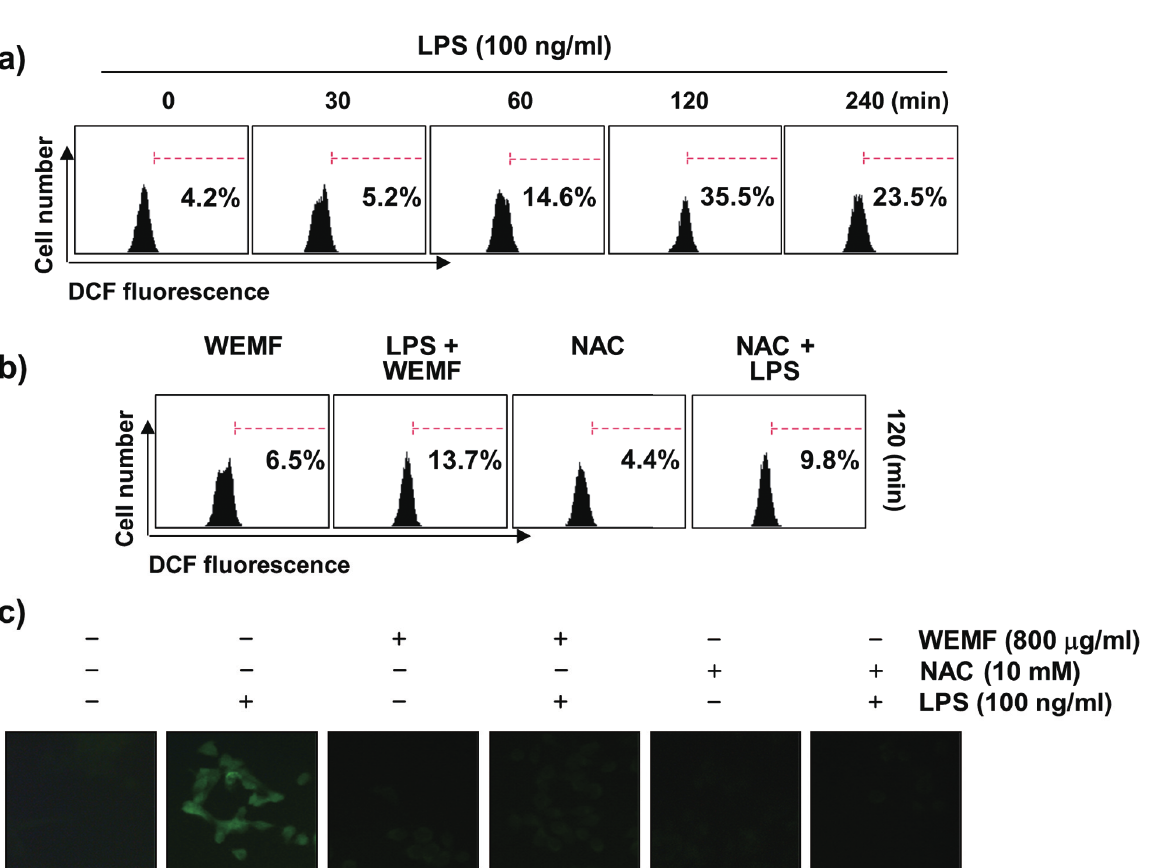
Figure 6 - Eff ects of WEMF on LPS-induced ROS production in RAW 264.7 macrophages. The cells were treated with 100 ng/ ml LPS for the indicated time (a) or pre-incubated with or without 800 μg/ml WEMF or 10 mM NAC for 1 h and then stimulated with 100 ng/ml LPS for 2 h (b and c). The cells were incubated with 10 μM DCF-DA for 30 min at 37°C. The cells were collected and DCF fl uorescence was measured by a fl ow cytometry. Values represent the means ± SD of two independent experiments. (c) Images were obtained using a fl uorescence microscope, presented from one experiment, and were representative of at least three independent